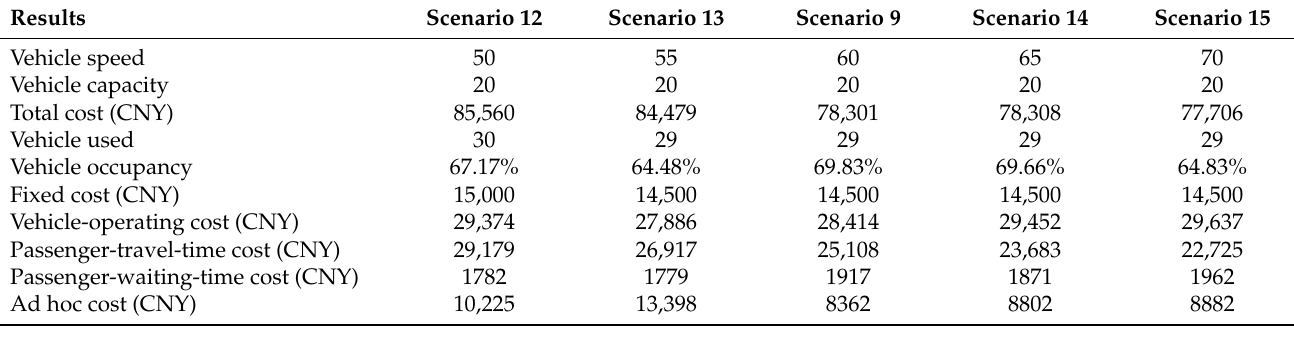
Table 11. Results under different vehicle speeds in Shenzhen airport.